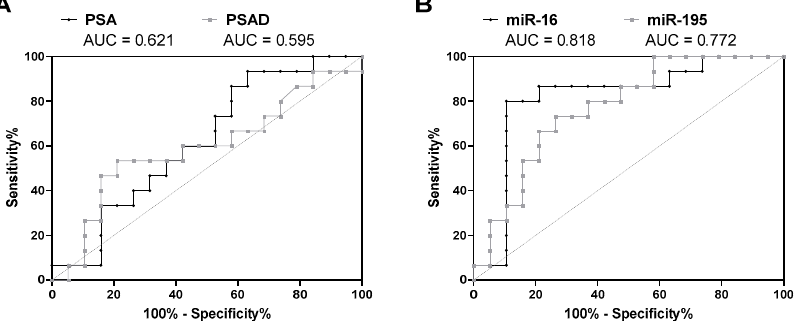
Figure 4. ROC curve analysis of ( A ) serum PSA levels and PSAD as well as of ( B ) miR-16 and miR-195 expression levels in urinary sediments using the sub-cohort of patients with PSA levels ≤ 10 ng/mL ( n = 34).